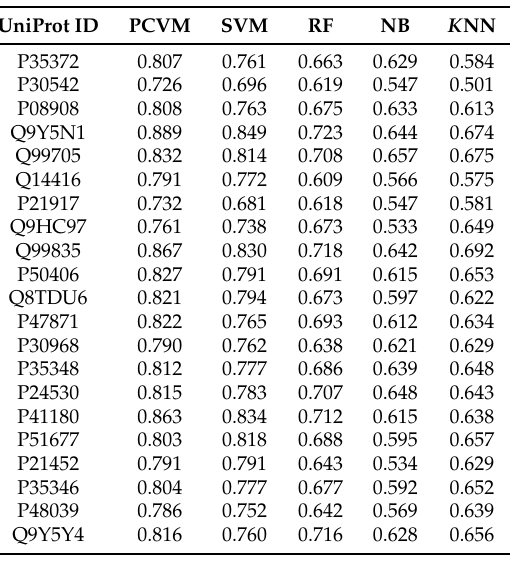
Table 3. Performance comparison of target prediction methods in terms of Precision. Scores for the external test